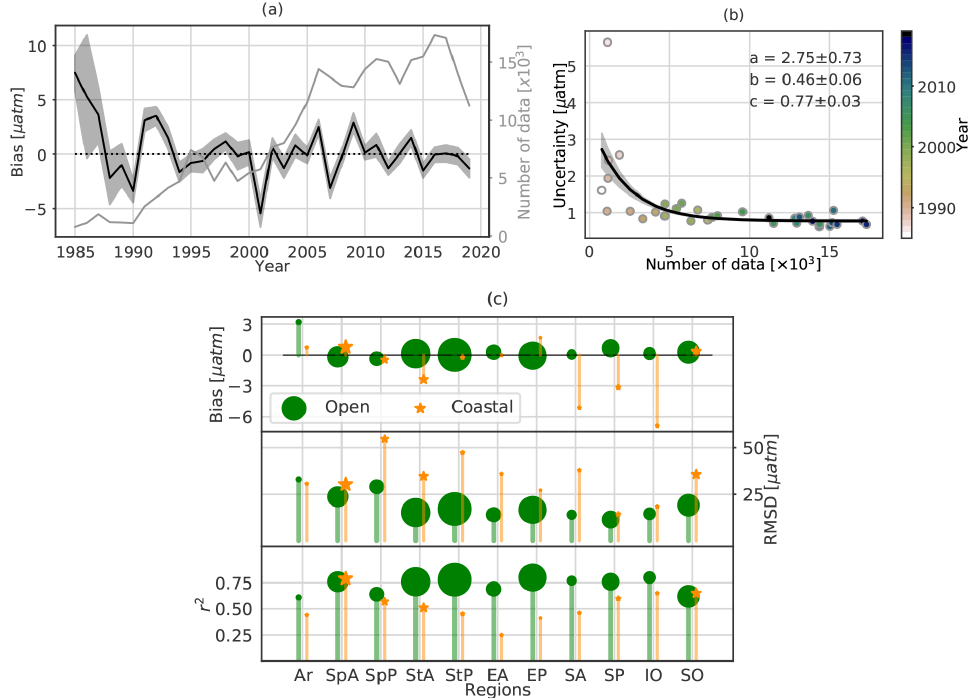
Figure 4. (a) Time series of the yearly mean model bias, i.e. the reconstructed p CO 2 data minus SOCATv2020 data, over the global ocean. The black curve and dark grey area represent the mean estimate and 1 σ envelope of errors of the 100-member ensemble; the light grey curve represents the total number of gridded SOCAT data used in the FFNN model construction. (b) Exponential fits of the model uncertainty (the magnitude of the 1 σ envelope in Fig. 4a) against the number of gridded data per year. The exponential function is y = a exp − bx + c . The black curve is derived from the best fit, and the grey-shaded area corresponds to the spread derived from standard errors of parameter estimates. (c) Statistical scores for 11 oceanic regions with the size of each scattered object proportional to the number of regional data (Table